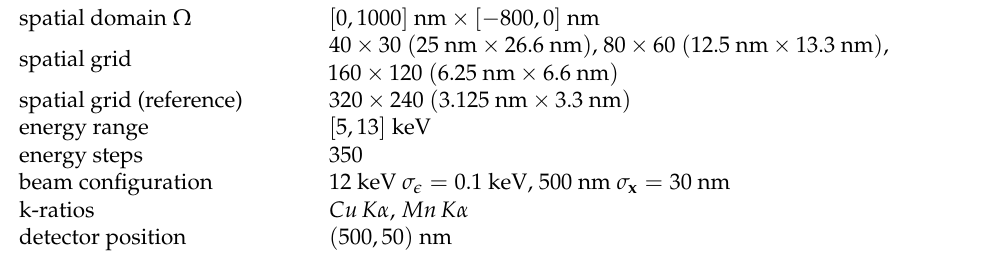
Table 1. Discretization and model parameters used for the convergence